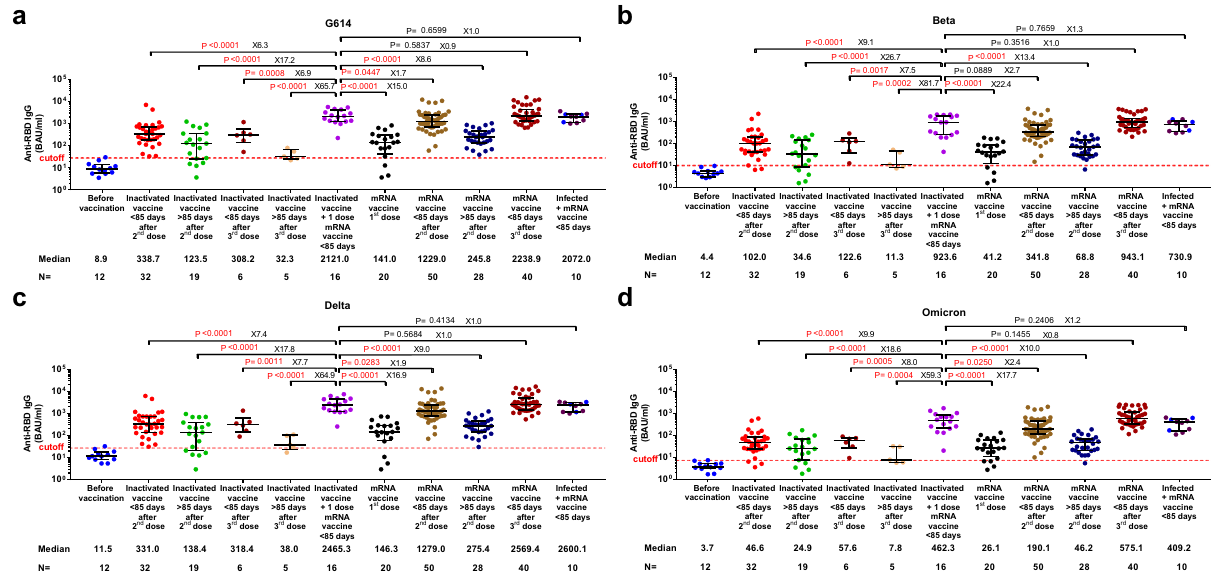
Fig. 1 Level of speci fi c IgG antibodies against receptor-binding domain (RBD) in different vaccination groups. Comparison of anti-RBD against G614 SARS-CoV-2 ( a ) and variants of concern ( b – d ) presented as binding antibody units (BAU)/ml. Symbols represent individual subjects and horizontal black lines indicate the median. The cutoff-value (dashed red line) and number of fold differences of median between groups are indicated. For each group, the number of samples (N = ) and median antibody titers are shown below the X -axis. In the last group, convalescent donors (prior history of infection) were color-coded based on receiving one (purple) or two doses (blue) of mRNA vaccines. Whiskers indicate the interquartile range. Two-sided Mann – Whitney U test was used and P < 0.05 was considered statistically signi fi cant and marked with red